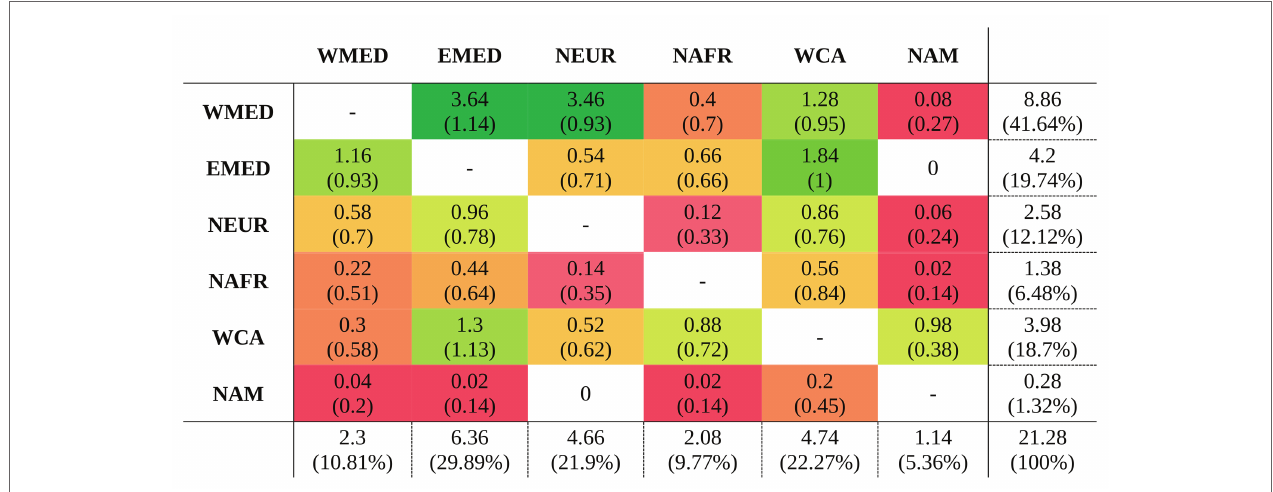
and ssp. rhodense ), whereas in the widespread clade, there is node of the species C. mairei , C. capense , and C. centauroides .